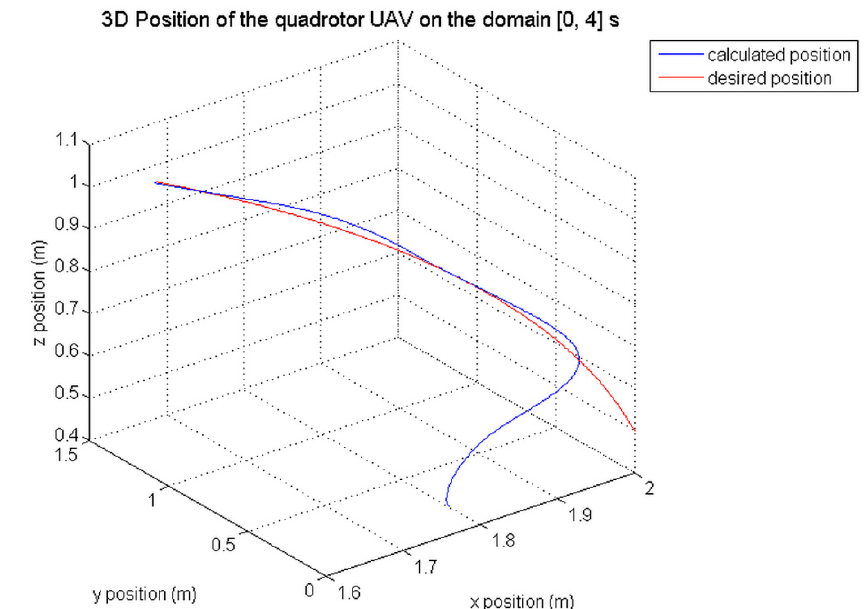
Figure 25. The 3D position of the quadrotor UAV obtained by the PTCM in the time interval [0, 4] s.